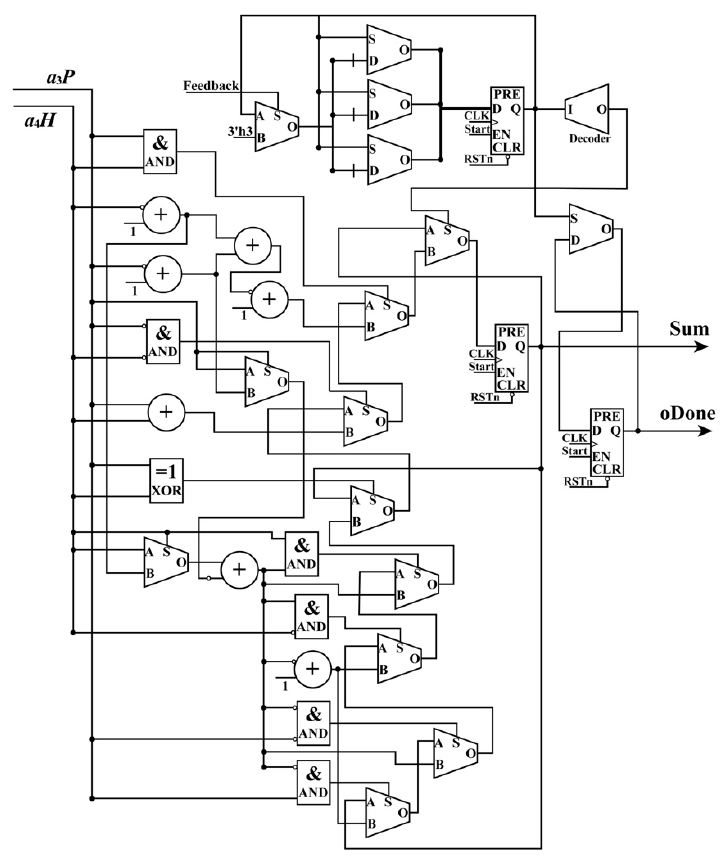
Figure 7. Details showing an example of extended addition.